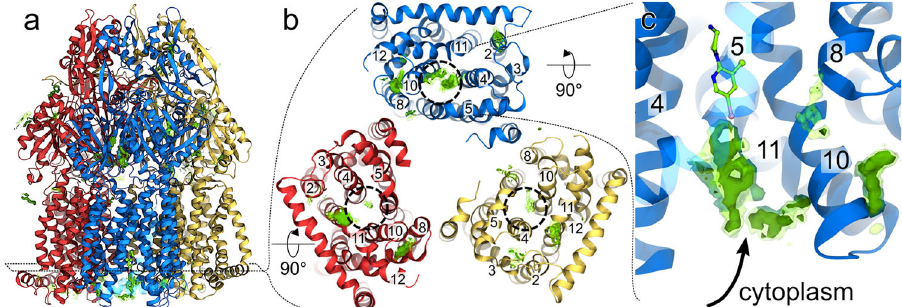
Fig. 3 Putative entry of BDM88832 (8) to its binding site in AcrB. Figure shows the preferred cumulative location (green surfaces) of BDM88832 ( 8 ) as seen in all-atom MD simulations of several compounds placed around AcrB embedded in a phospholipid bilayer. a Side view of BDM88832 ( 8 ) density on the whole AcrB tripartite ef fl ux pump (L, T, and O protomers are shown as blue, yellow and red, respectively). b BDM88832 ( 8 ) density distribution viewed from the cytoplasmic side with only the TM domain shown for clarity. Relevant TM helices are labelled, and dashed circles on each monomer delimit the location of the experimental binding site. c Zoomed side view of the L protomer showing accumulation of BDM88832 ( 8 ). The X-ray conformation of BDM88832 ( 8 ) in AcrB is superimposed in CPK coloured by atom type (C, N, I, and Cl in green, blue, pink, and yellow, respectively). TM helix 5 is shown transparent for clarity. All data are cumulative results from 5 independent MD simulations of 2 μ s each; transparent and solid green surfaces represent iso- values of 3 and 5, (Fig. 3), and the presence of water accessible channels from the